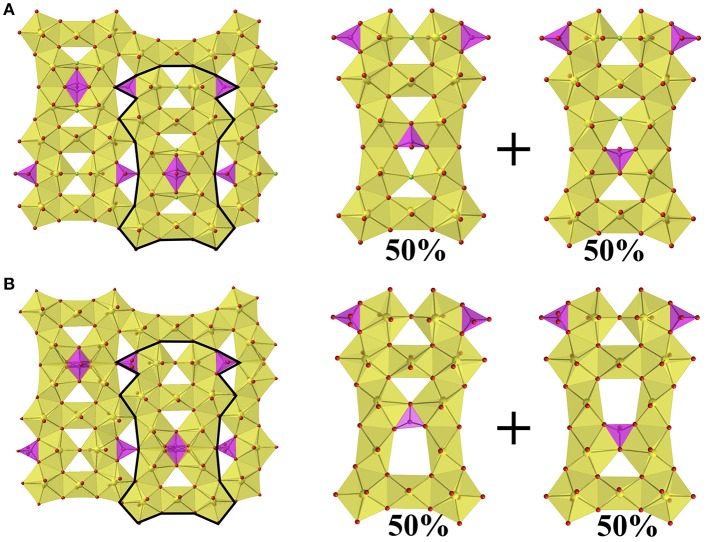
(A) Sheets found in Rb11[UO2)12(PO4)3O12F2] (2) showing the two possible orientations of the phosphate tetrahedron, where F in presence in the absence of the phosphate tetrahedron. (B) The sheets found in Cs11[(UO2)12(PO4)3O13] (1) showing the two possible orientations of the phosphate tetrahedron.